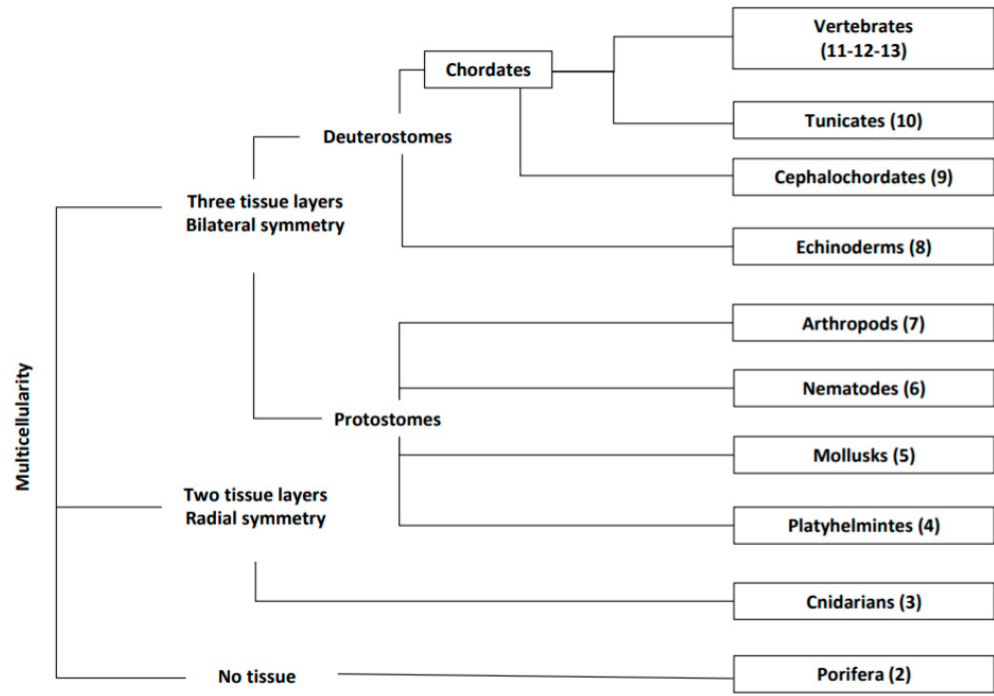
Figure 1. Tree of the animals’ clades treated in this review (in brackets the corresponding section